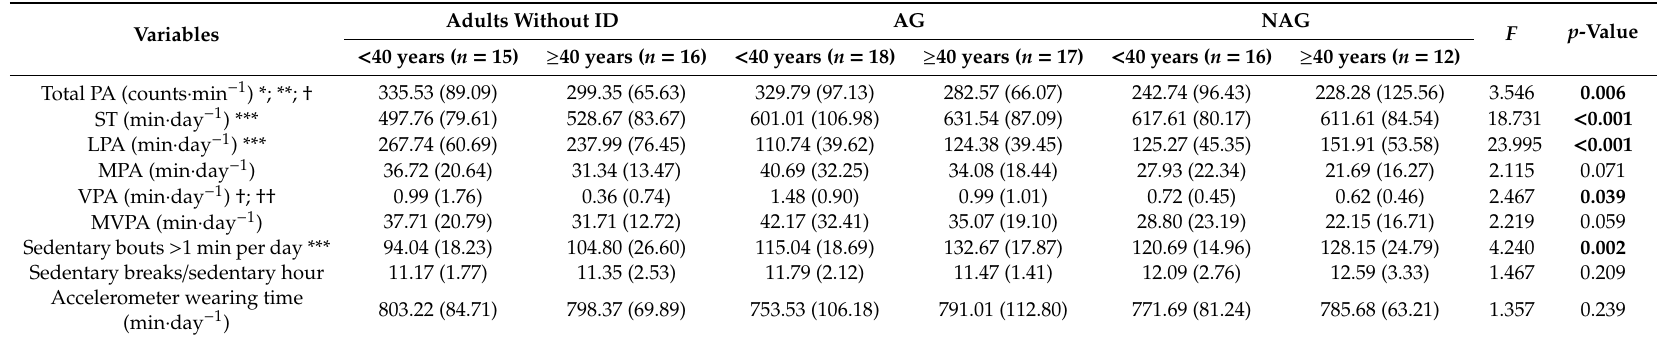
Table 4. Patterns of sedentary time and physical activity levels by group and